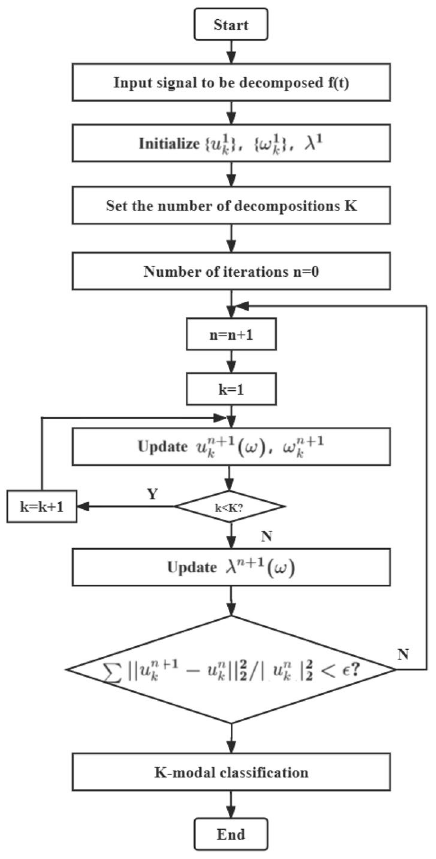
Fig. 3 VMD flow chart